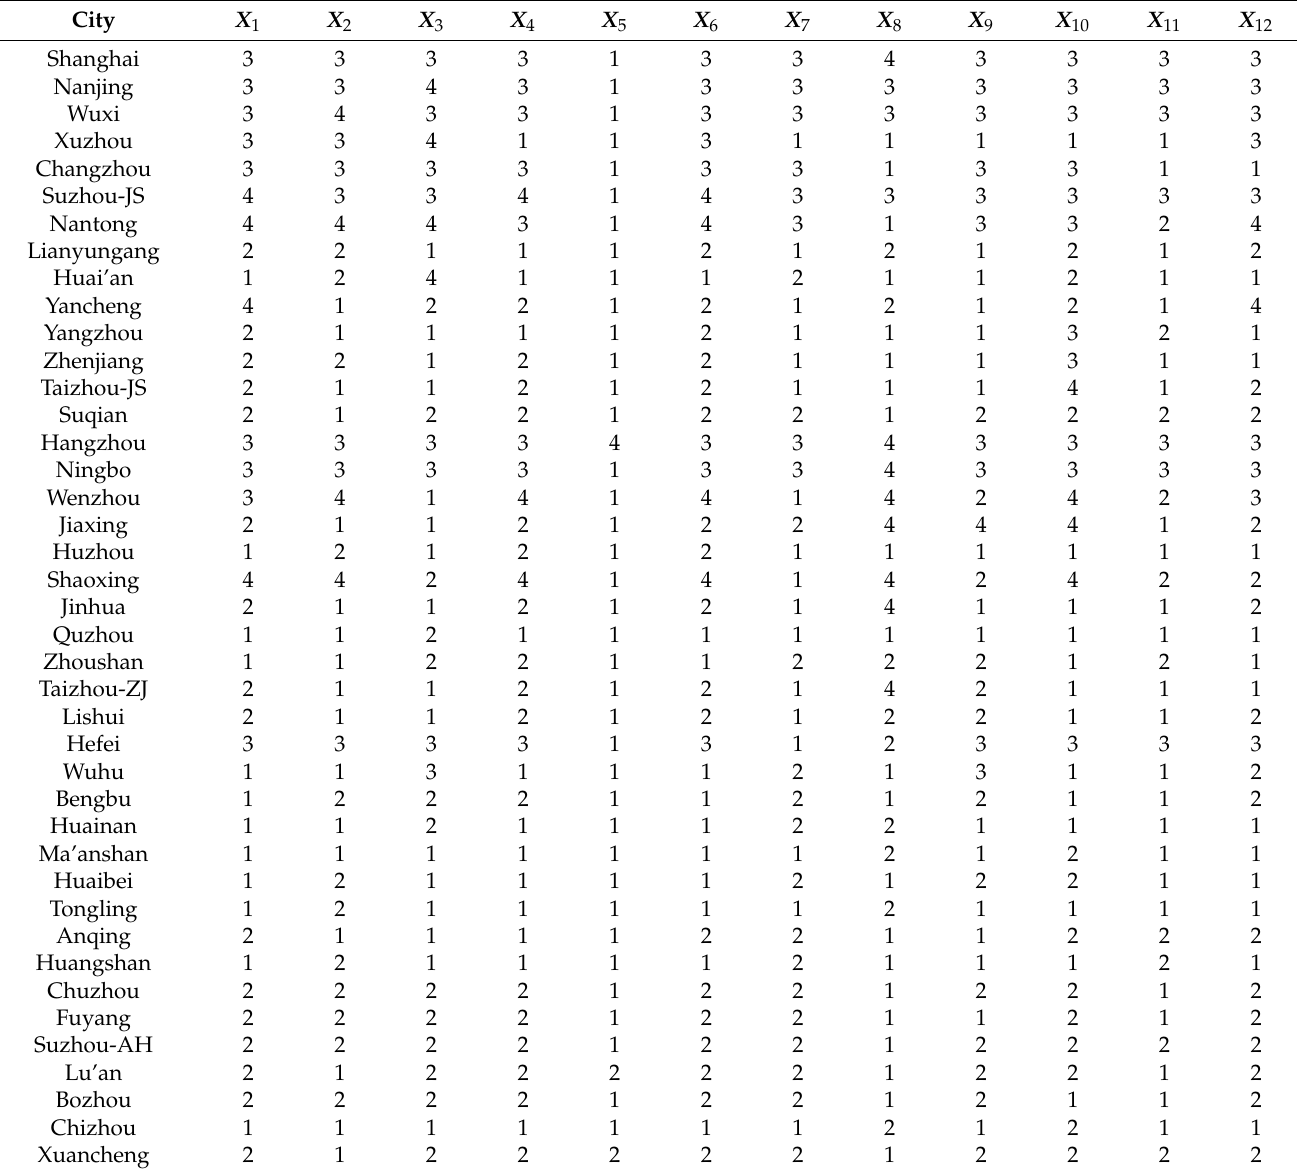
Table A1. Analysis of the evolution mode of independent variables in